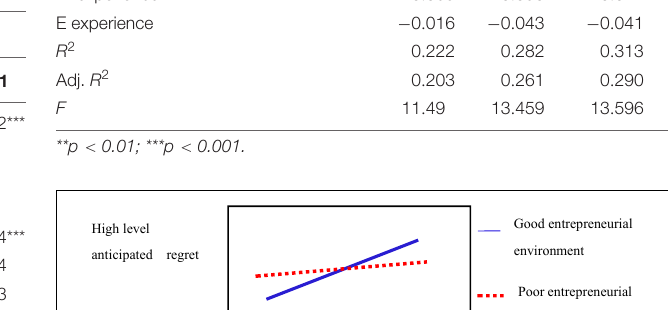
TABLE 4 | Results of the regression analysis of entrepreneurial cognitive mediation.